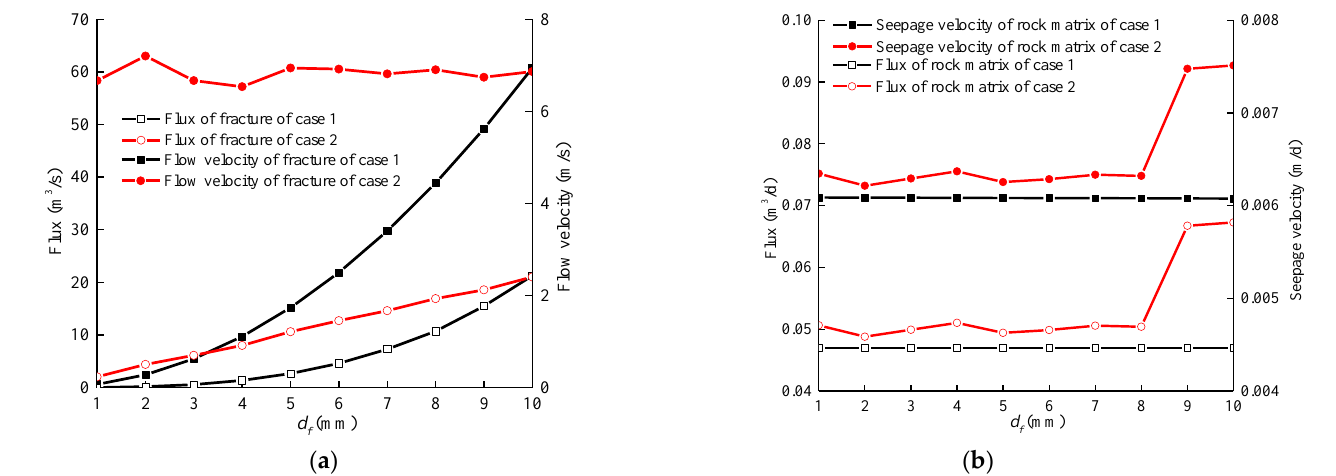
Figure 5. Velocity characteristic of fractured rock mass with different fracture aperture under ∆ H = 3 m: ( a ) fracture and ( b ) rock matrix, where d f = fracture aperture.